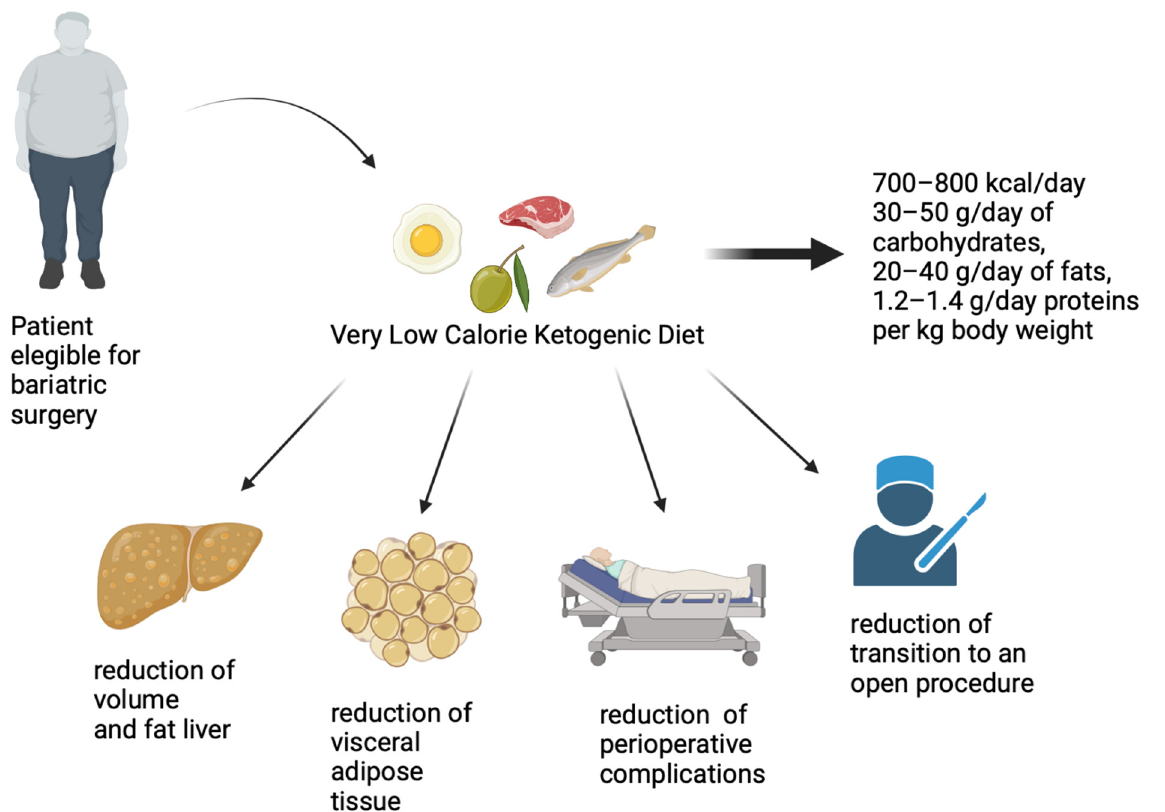
Figure 1. Pre-operative effects of very low-calorie ketogenic diet in a candidate for bariatric surgery. 2.3. Indications and Contraindications of Very Low-Calorie Ketogenic Diet in Pre-Bariatric Sur-